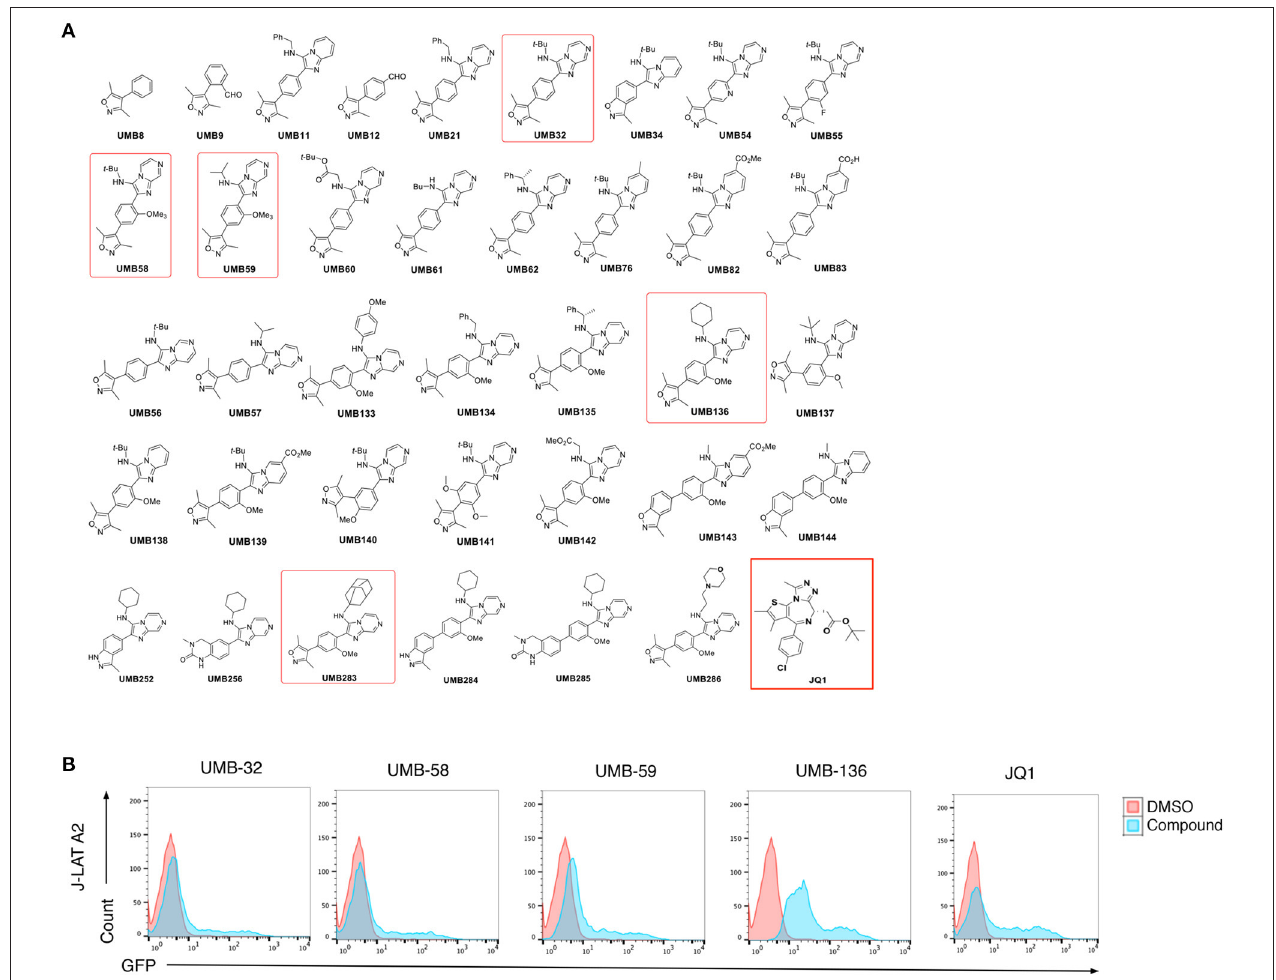
FIGURE 1 | UMB-136 is a leading UMB-32 based BETi. (B) J-Lat A2 cells were treated with UMB-32, 58, 59, or 136 (5 µ M), or JQ1 (1 µ M). GFP-positive cells were acquired and analyzed by flow cytometry. The HIV-reactivated cell population was indicated. (A) Chemical structures of 37 UMB-32 analogs. The structures of UMB-32, 58, 59, 136, and JQ1 were highlighted in red